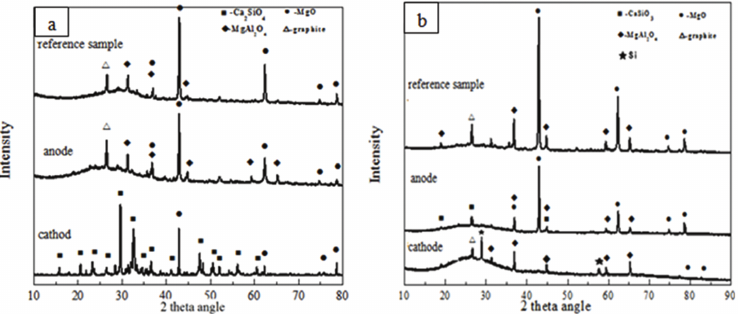
Figure 7: XRD analysis of corroded MgO-C samples in a: CaO-SiO 2 -Al 2 O 3 slag and b: CaO-SiO 2 -Al 2 O 3 -10%MgO slag